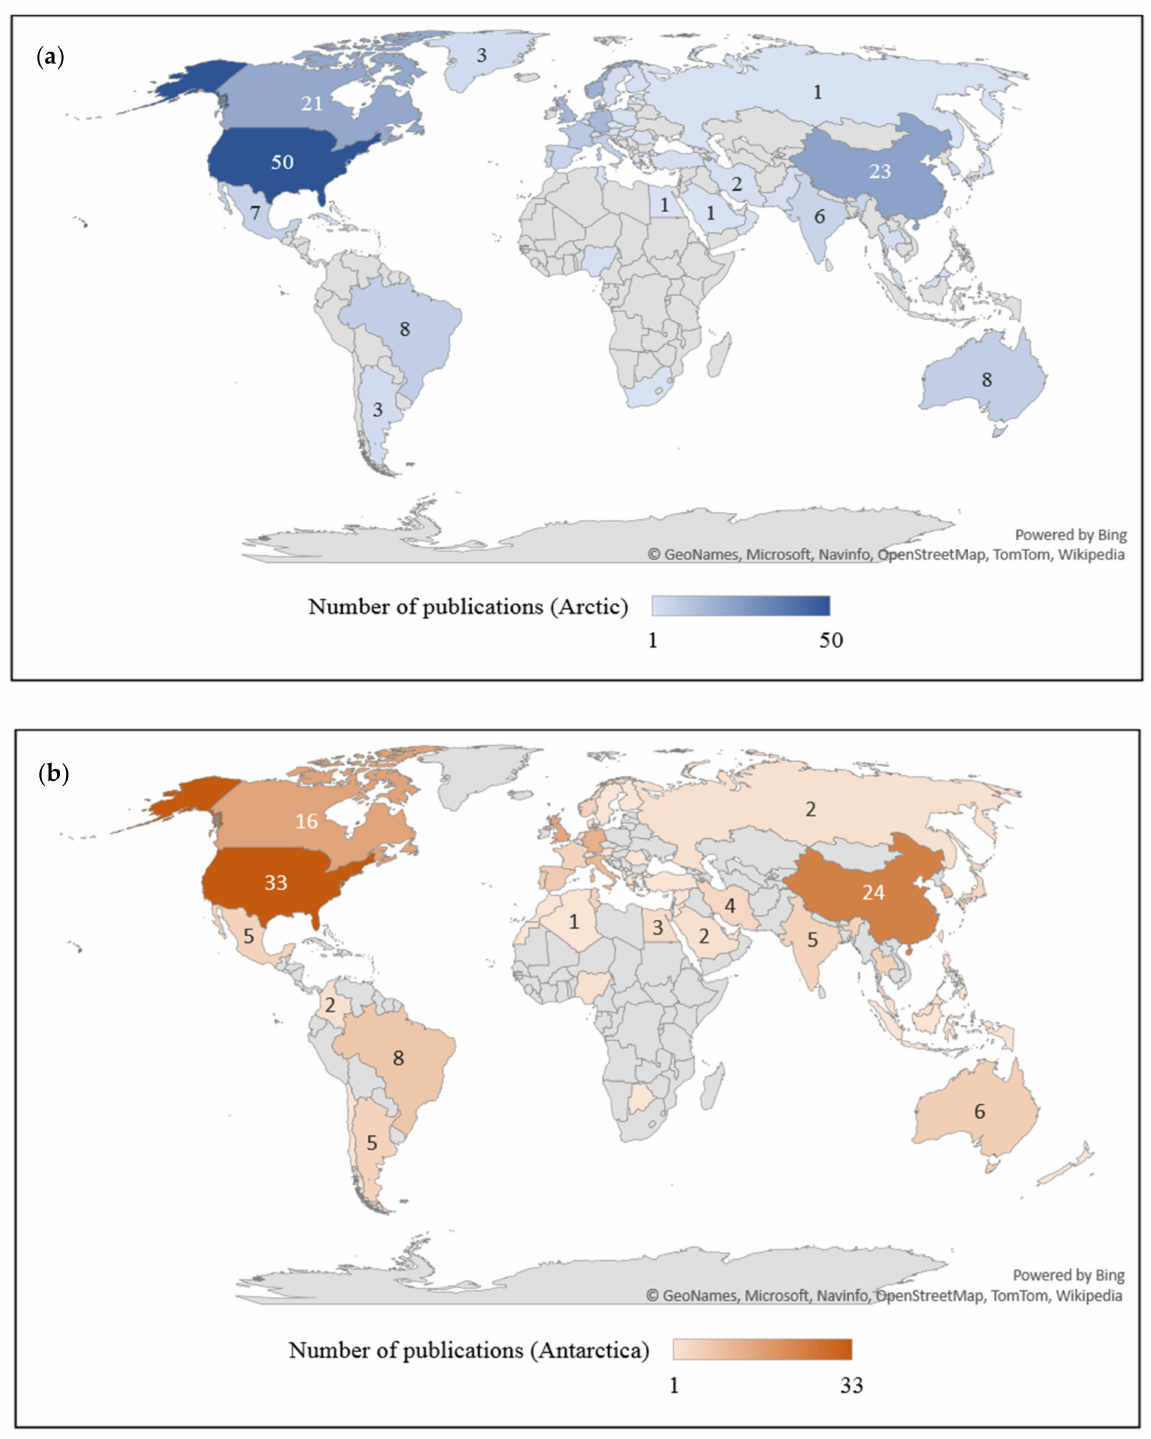
Figure 5. Number of journal articles published by countries or territories related to hydrocarbon degradation by ( a ) Arctic and ( b ) Antarctic marine microbial